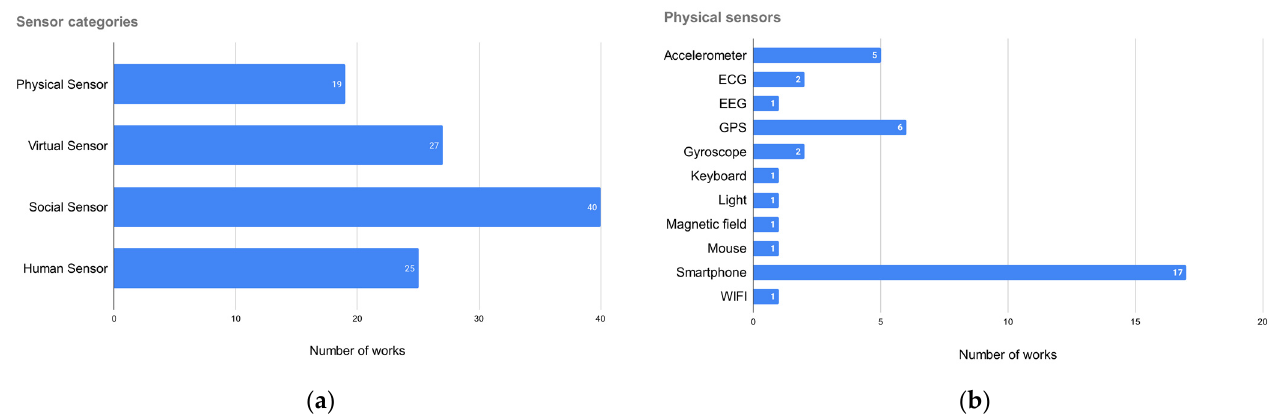
Figure 4. ( a ) Works employing different sensor categories ( b ) works employing different physical sensors.